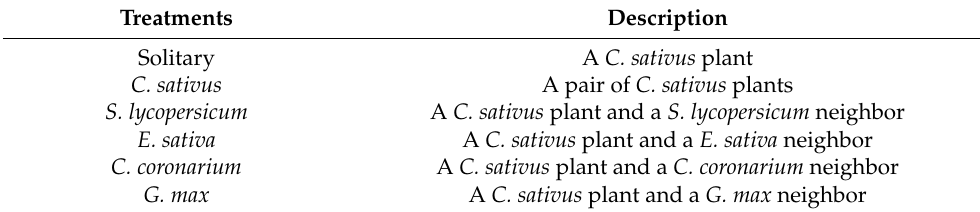
Table 1. Definite description of different